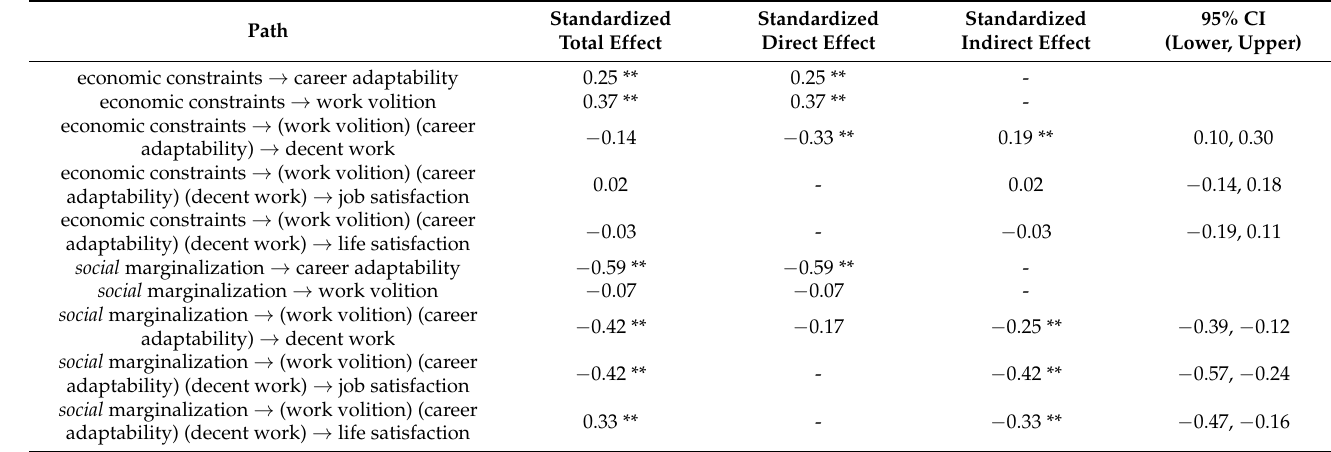
Table 4. Bootstrap analyses of the statistical significance of the indirect effect ( N =